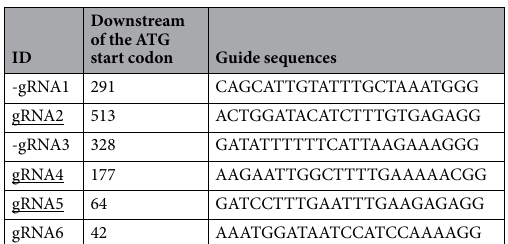
Table 1. gRNAs for Mat α 3 gene knockout. * gRNAs that facilitated the cleavage are underlined. gRNAs that target the antisense strand are indicated by “ − ” in their